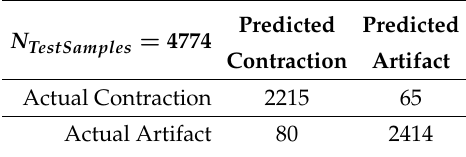
Table 12. Confusion matrix for selected decision tree (3 input